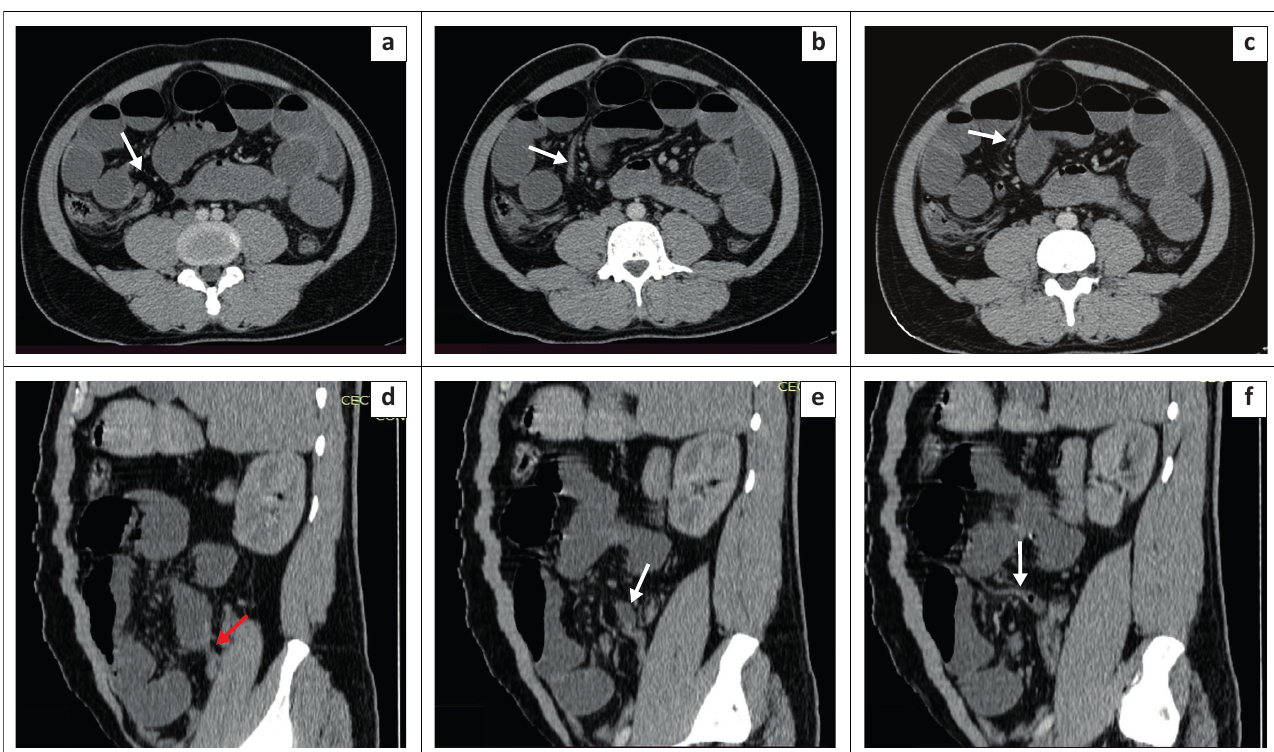
FIGURE 6: Contrast enhanced computed tomography in the axial (a, b, c) and coronal (d, e and f) planes show dilated small bowel loops with air-fluid levels. An inflamed Meckel’s diverticulum (white arrows) was seen arising at the level of the transition point (red arrow). An enhancing linear band was seen arising from the Meckel’s diverticulum, extending towards umbilicus (white arrow in